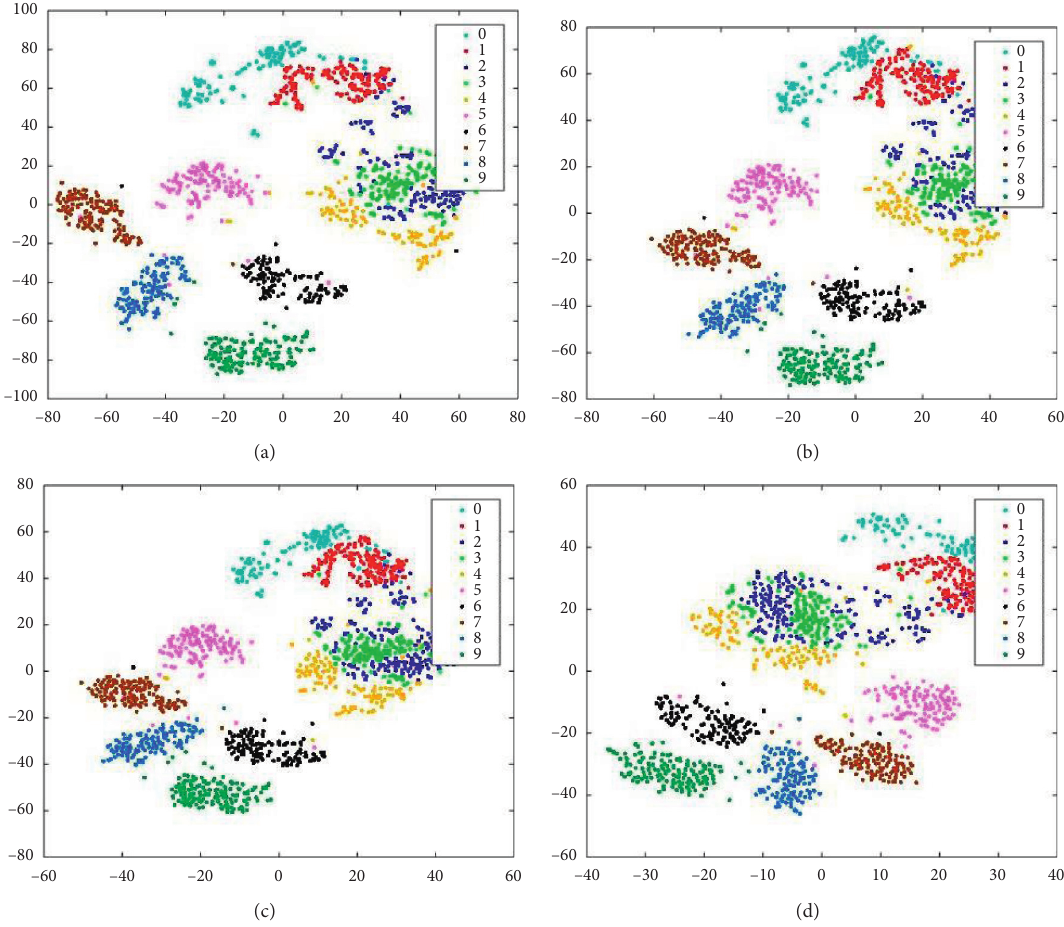
Figure 7: Standard (t) -SNE based visualization results of the combined data of pixel- and structure-based information of the Urdu handwritten numerals. (a) Perplexity: 30 Iterations:1,000. (b) Perplexity: 50 Iterations:1,000. (c) Perplexity: 70 Iterations:1,000. (d) Perplexity:100 Iterations: 1,000.